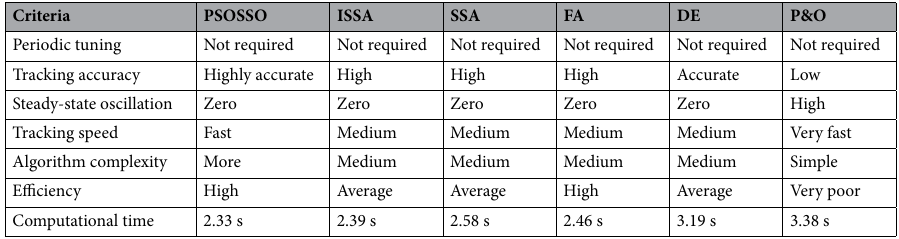
Table 2. Comparative analysis in terms of various criteria 37